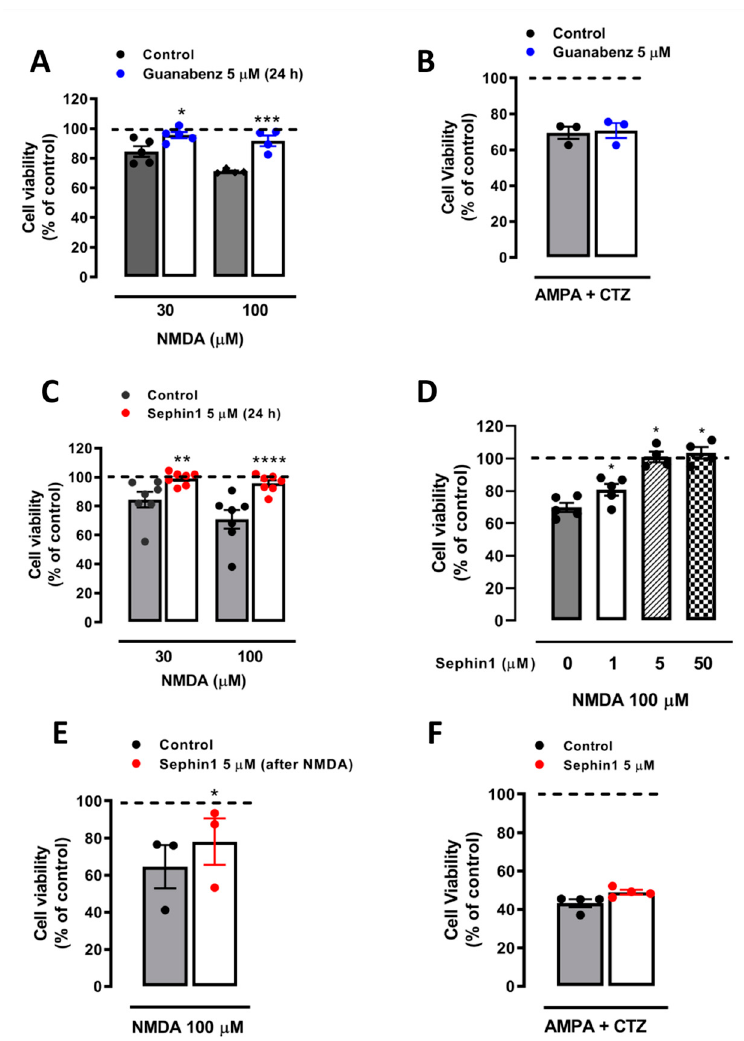
Figure 2. Sephin1 and guanabenz strongly attenuate NMDA-induced (but not AMPA / CTZ-induced) excitotoxicity. ( A ) Neurons were stimulated with NMDA (30 and 100 µ M, 30 min) in the presence or absence of guanabenz (5 µ M, present before, during, and after NMDA addition). * p < 0.05, *** p < 0.001 compared with control (NMDA alone), one-way ANOVA followed by Bonferroni´s post hoc test. ( B ) Neurons were treated with AMPA (25 µ M, 30 min) and cyclothiazide (CTZ, 100 µ M) in the presence or absence of guanabenz (5 µ M, present before, during, and after AMPA / CTZ addition) and paired Student’s t-test. ( C ) Neurons were stimulated with NMDA (30 and 100 µ M, 30 min) in the presence or absence of Sephin1 (5 µ M, present before, during, and after NMDA addition). ** p < 0.01, **** p < 0.0001 compared with control (NMDA alone), one-way ANOVA followed by Bonferroni´s post hoc test. ( D ) Neurons were stimulated with 100 µ M of NMDA for 30 min in the presence or absence of increasing concentrations of Sephin1 (1, 5, and 50 µ M, added 1 h before NMDA addition and washed after NMDA). * p < 0.05 compared with control (NMDA alone), one-way ANOVA followed by Bonferroni´s post hoc test. ( E ) Neurons were stimulated with 100 µ M of NMDA for 30 min in the presence or absence of Sephin1 (5 µ M, added after NMDA wash). * p < 0.05 compared with control (NMDA alone), paired Student’s t-test. ( F ) Cells were treated with 25 µ M of AMPA plus CTZ in the presence or absence of Sephin1 (5 µ M, added 1 h before AMPA / CTZ addition), paired Student’s t-test. In all cases, cell viability was assessed 24 h later by the quantification of vital dye calcein-AM fluorescence. Data represent means ± SEM of normalized calcein fluorescence values. On the other hand, both guanabenz and Sephin1 protect against ER stress-induced cell death by ISR enhancement in models of proteostasis disruption [14,17]. In cortical neurons exposed to